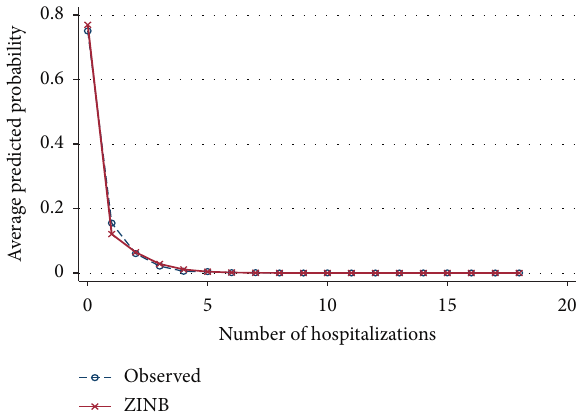
Figure 5: Average frequency of ZINB against the observed.